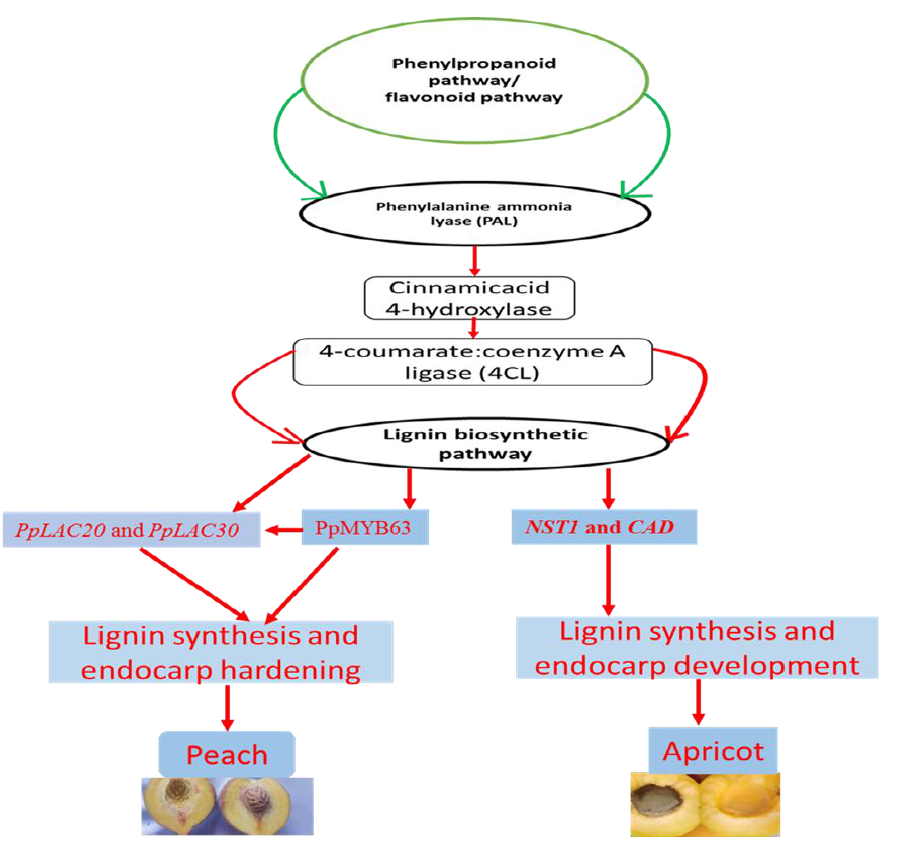
Figure 3. Role of phenylpropanoid/flavonoid biosynthetic genes involved in lignin synthesis and endocarp hardening. The peach and apricot are shown as an example in this figure. The PpLAC20 and PpLAC30 are activated by the PpMYB63 transcription factor and are candidate genes involved in peach lignin biosynthesis and hardening of the peach endocarp. The NST1 activates expression levels of CAD (Cinnamyl alcohol dehydrogenase) genes resulting in the synthesis of lignin and endocarp development in the apricot. The role of genes was described recently in peaches by Qui et al. [4] and in apricot by Zhang et al. [33].